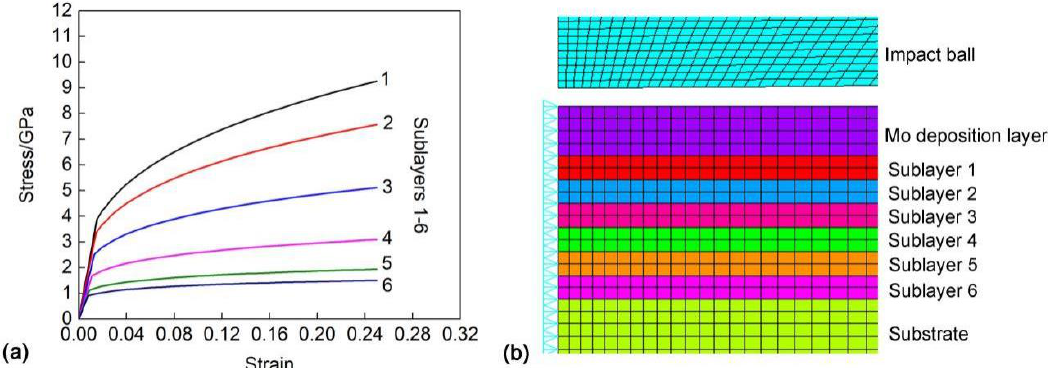
Figure 10. Material models ( a ) true stress-strain curves of the Mo diffusion layer with 6 sublayers assumed, ( b ) finite element mesh with material attributes defined.